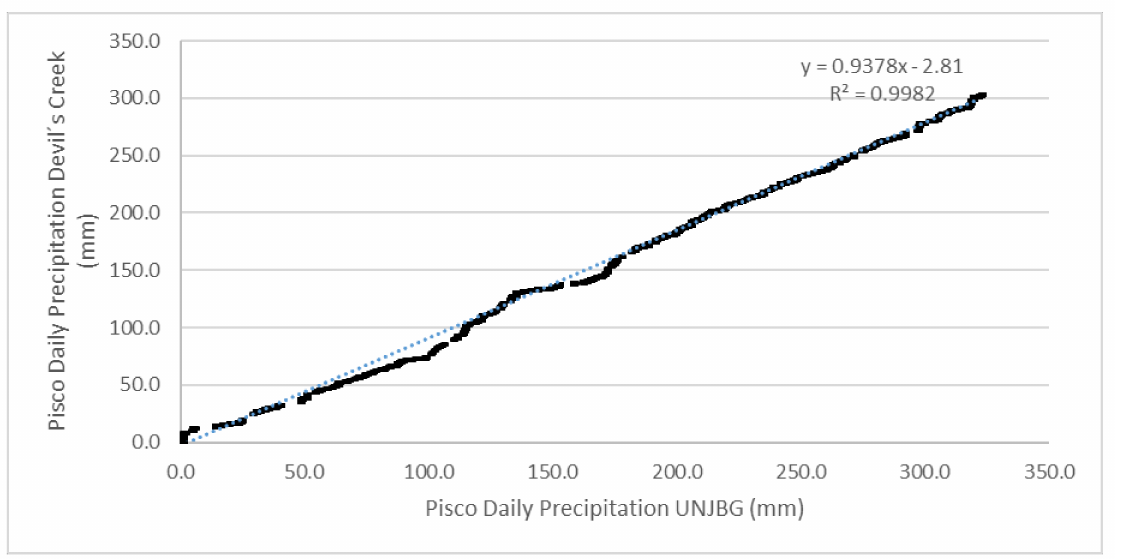
Figure 5. Comparation double-mass between the precipitation data of the PISCO product in the JORGE BASADRE rain gauge versus the precipitation data of the PISCO product in Devil’s Creek over 7780 days (1 January 1993–21 April